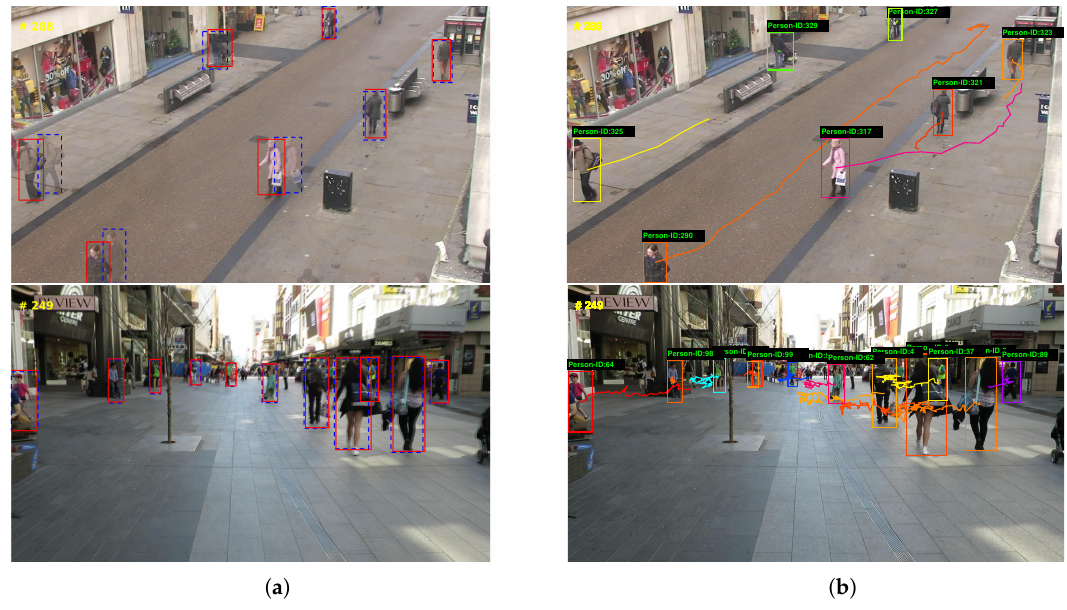
Figure 8. Experimental results on MOT2015 dataset. Left column ( a ) shows the tracking results with CCF, and right column ( b ) shows object trajectories. The experimental results demonstrate our approach is effective for tracking small